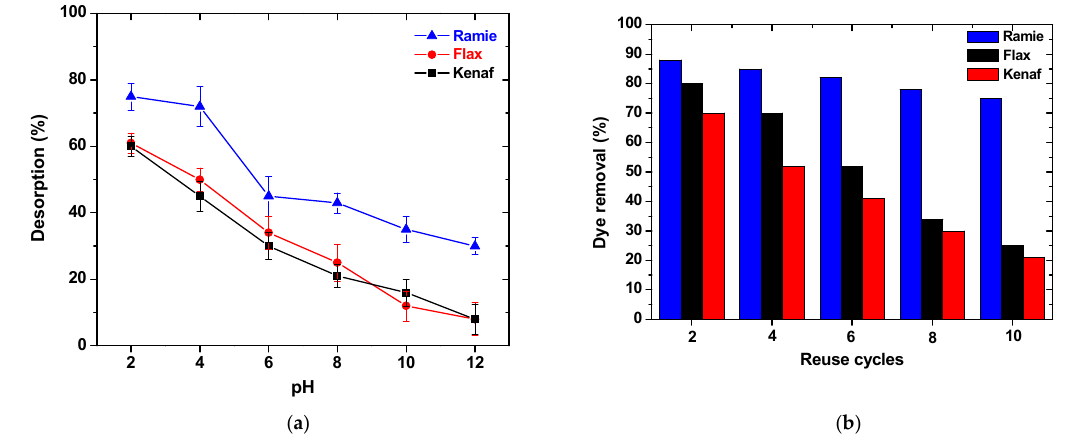
Figure 9. ( a ) Effect of pH on BY37 desorption from fibers. ( b ) Reuse cycles of adsorption-desorption (adsorption conditions: C 0 = 100 mg · L − 1 , pH = 12, T = 25 ◦ C, N = 160 rpm, m = 0.1 g, V = 100 mL, and t = 24 h; and desorption conditions: pH = 2–12 (2 as optimum for cycles), T = 25 ◦ C, N = 160